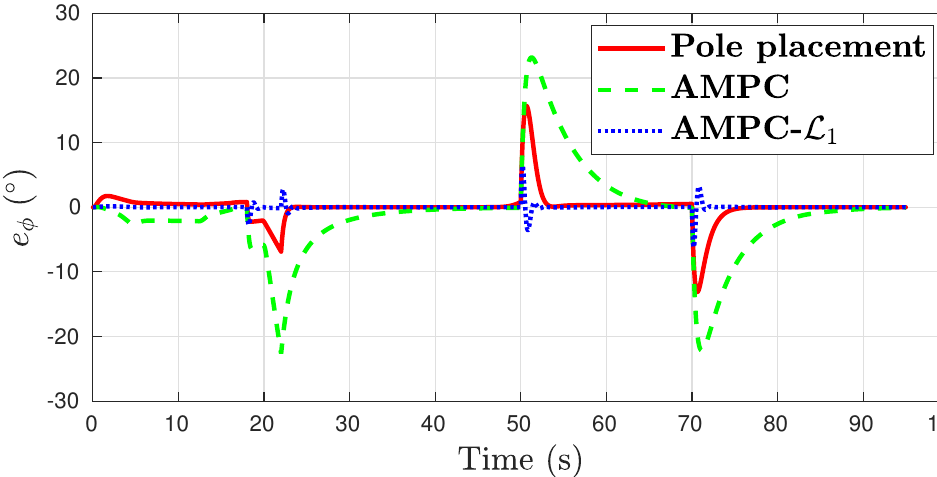
Figure 13. Roll tracking error for guidance uncertainty case.